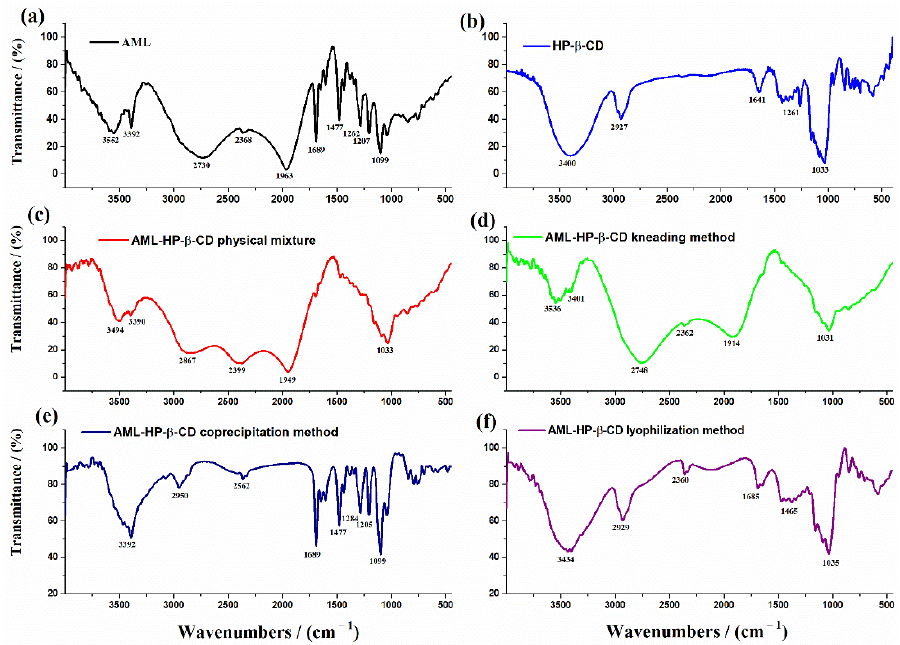
Figure 1. FTIR spectra of ( a ) AML, ( b ) HP- β -CD, ( c ) AML-HP- β -CD physical mixture, ( d ) AML-HP- β -CD kneading method, ( e ) AML-HP- β -CD coprecipitation method, and ( f ) AML-HP- β -CD lyoph- ilization method.